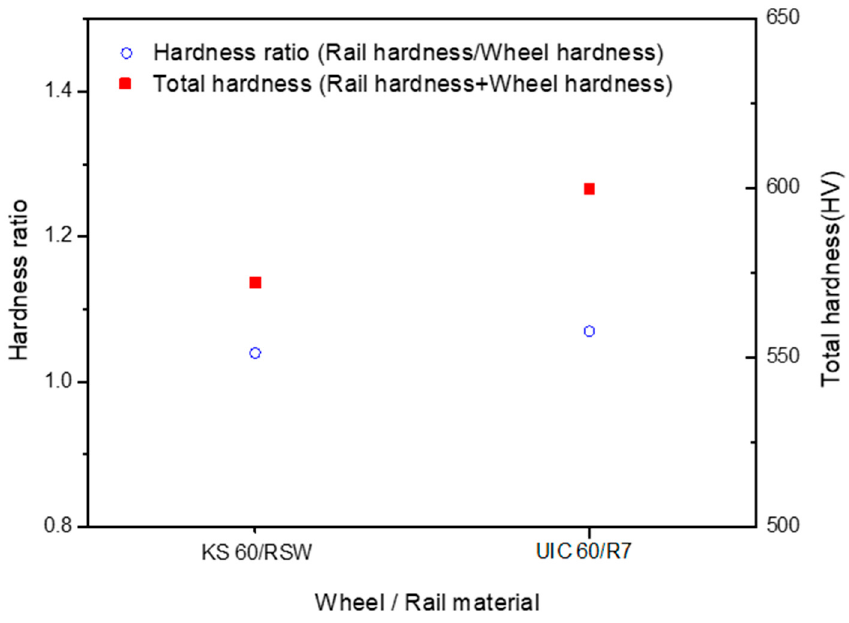
Figure 18. Hardness ratio and total hardness.